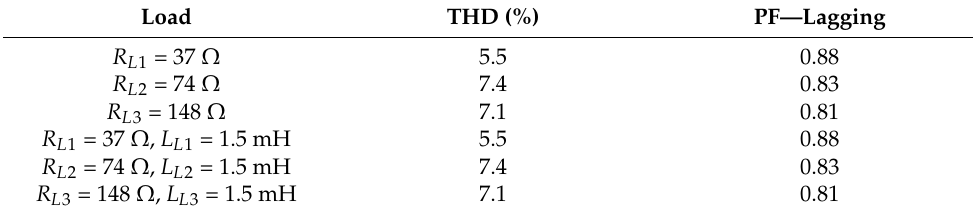
Table 9. CTU total harmonic distortion and power factor.